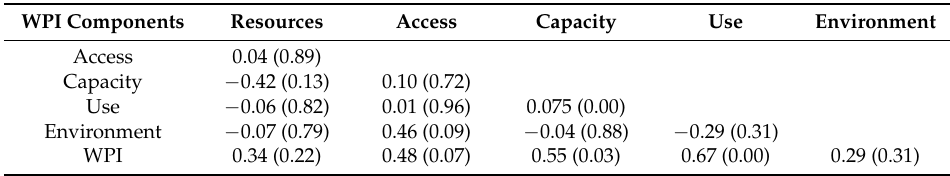
Table 8. Correlation between different components of